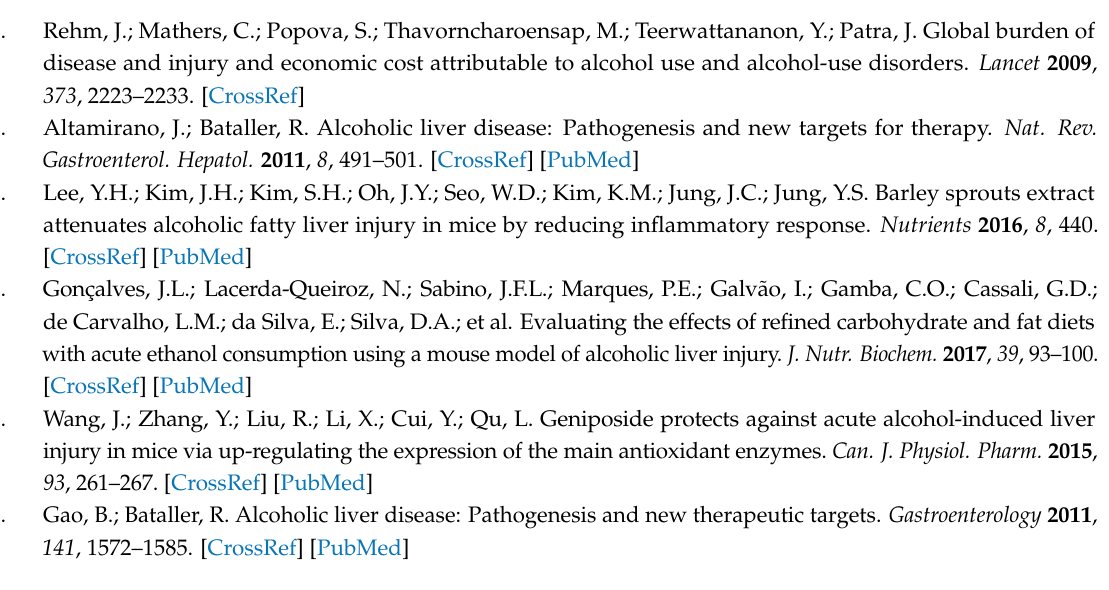
Figure S1: Effects of single-dose and 14-day SAV in alcohol-treated